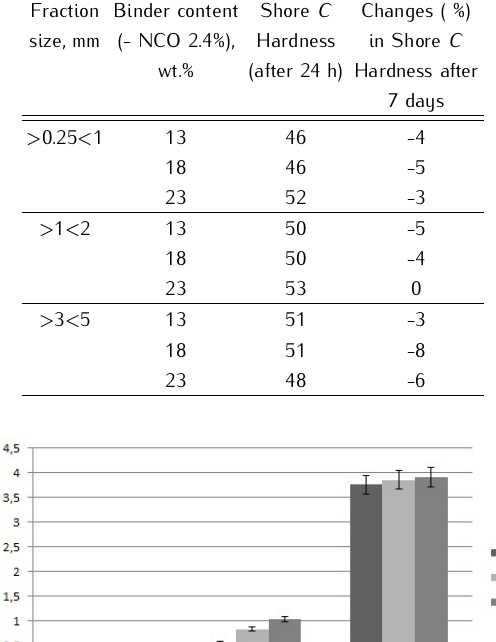
Table 1. The Results of Shore C hardness for specimens prepared from fractionated rubber crumb (T a = 17 - 20 ◦ C, P= 0.004